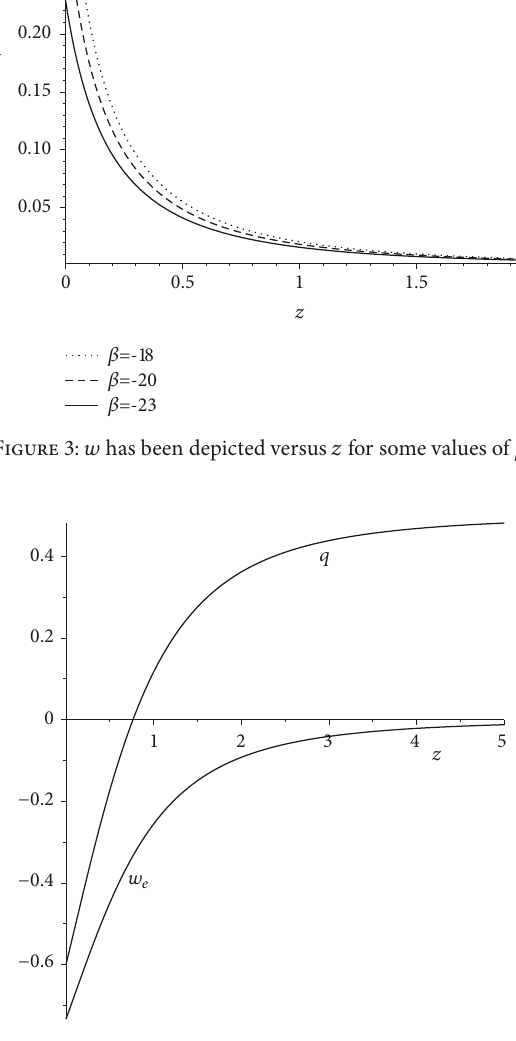
Figure 4: 𝑤 𝑒 and 𝑞 versus 𝑧